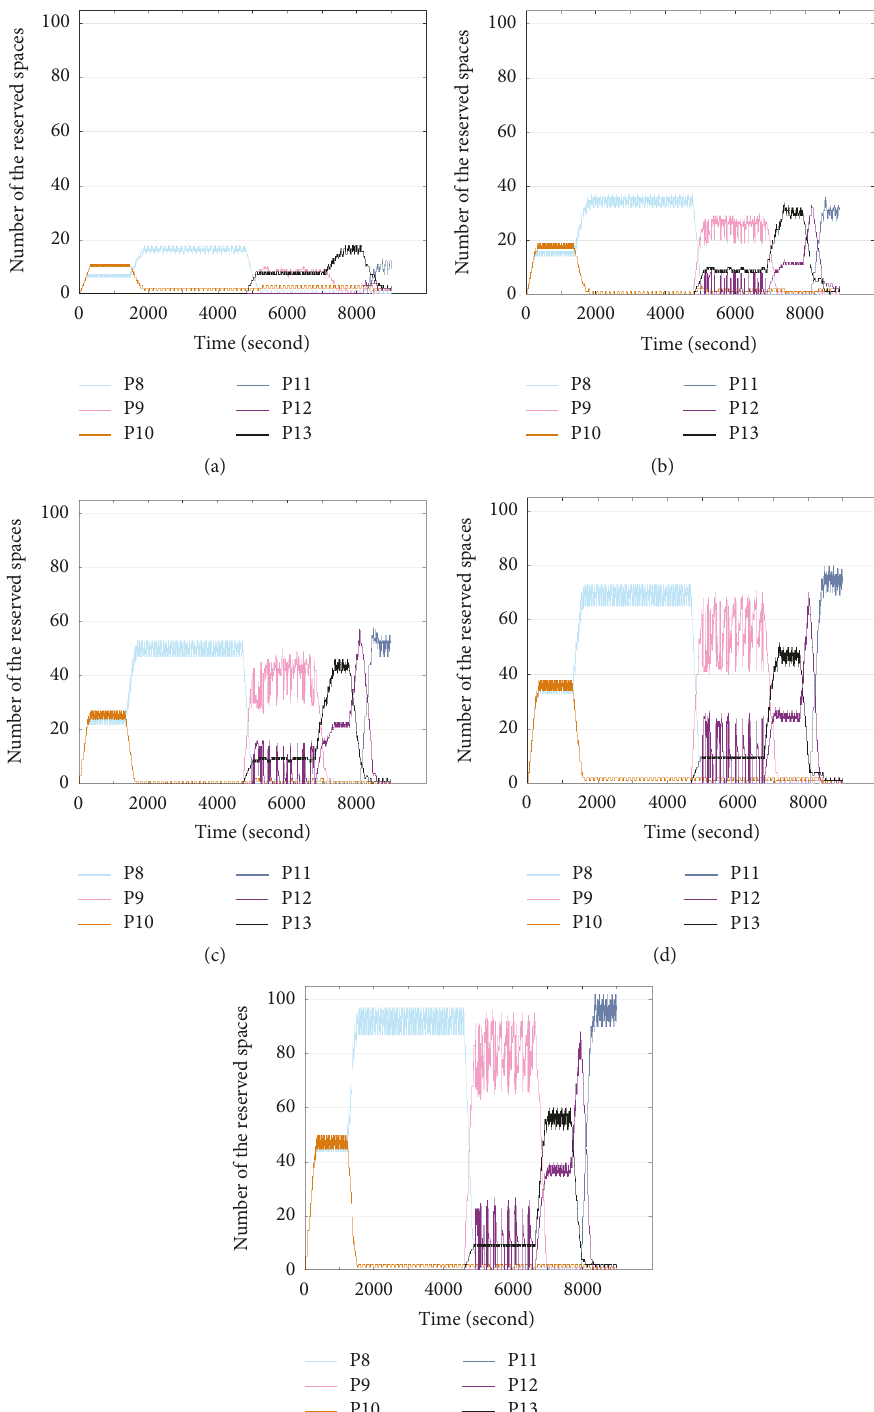
Figure 6: Number of the reserved spaces with the scenarios, (a) Scenario 1, (b) Scenario 2, (c) Scenario 3, (d) Scenario 4, and (e) Scenario